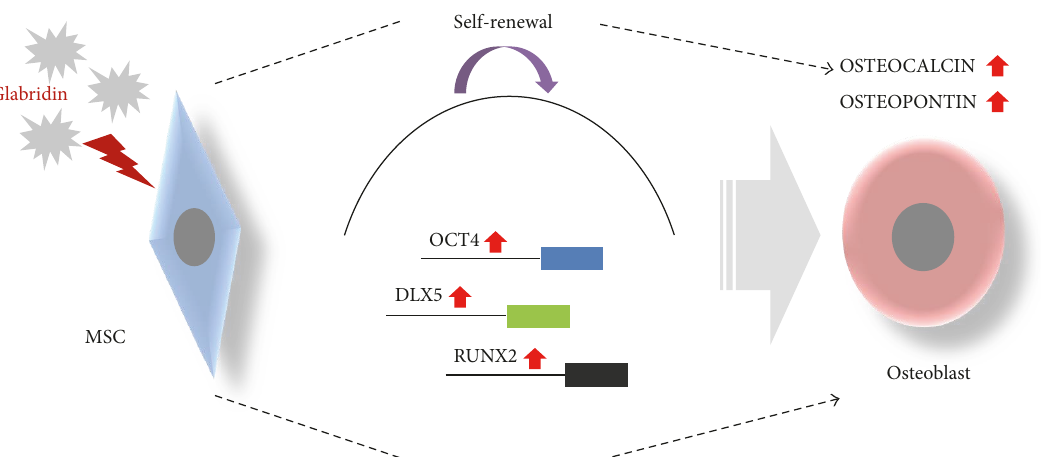
Figure 7: Schematic summary of the e ff ect of glabridin on osteogenesis of MSCs. Our results suggest that glabridin upregulates the expression level of the OCT4 gene associated with stemness and that of DLX5 and RUNX2 genes related to osteogenesis. Glabridin enhances OCT4 - induced osteogenesis of MSCs by activating OSTEOCALCIN and OSTEOPONTIN genes for osteogenic di ff